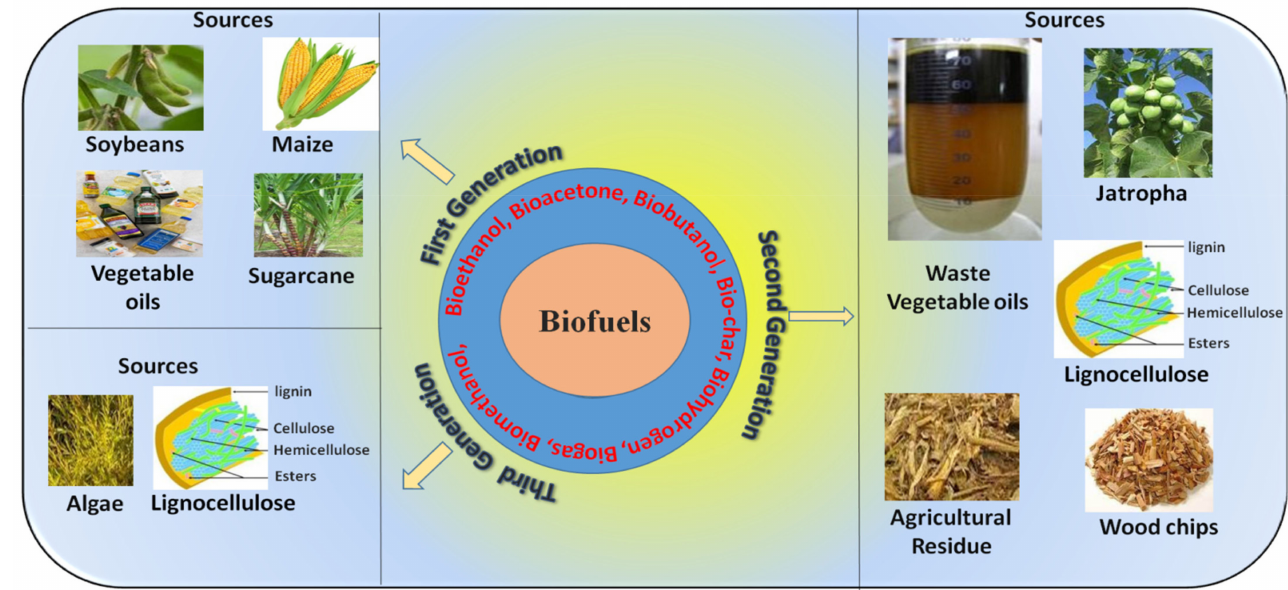
Figure 1. Representation of biofuel types and their